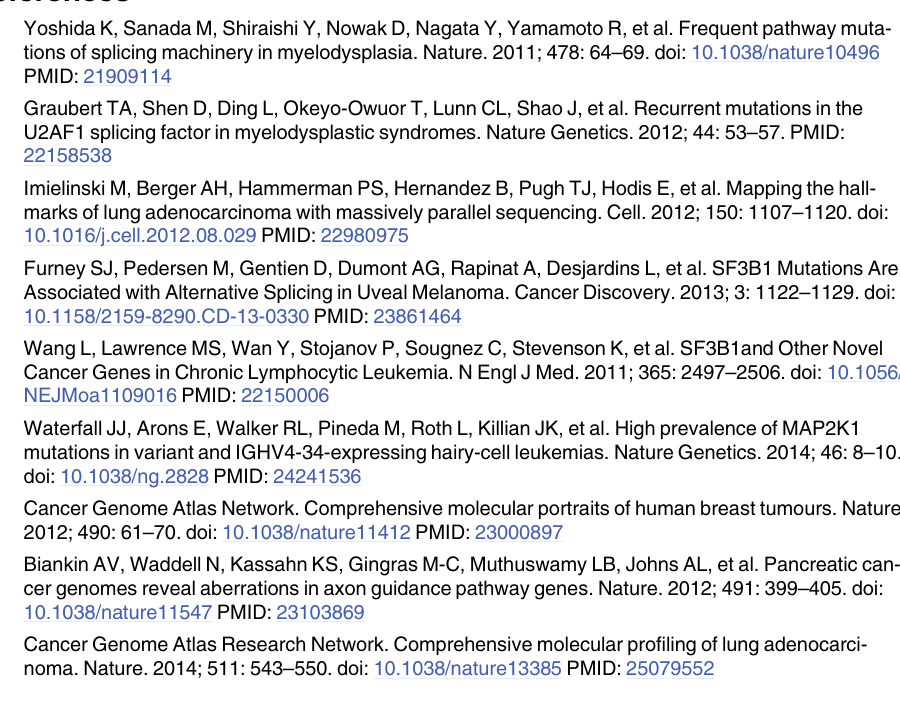
S7 Table. List of primer sequencesused for examining splicing alterations. The columns “Gene Name”, “Coordinates” and “Type” are defined the same way as those in S1 Table. The “short” isoforms refer to those with skipping of cassette exon or selection of an intron-distal 3 0 splice site. The “long” isoforms refer to those with increased inclusion of cassette exon or selec- tion of an intron-proximal 3 0 splice